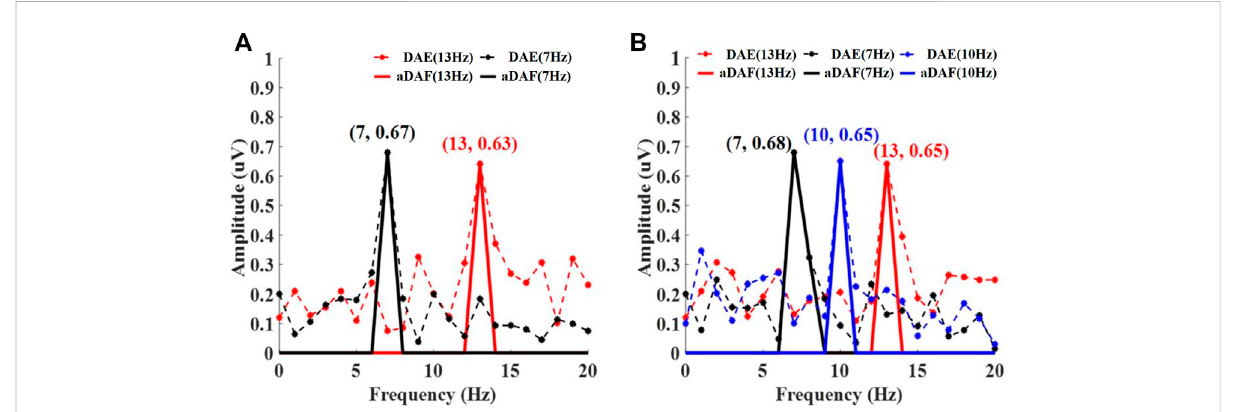
FIGURE 5 The decoded frequency spectrum results for multi-source with different frequencies, including (A) 2-sourceand (B) 3-source. In (A) , Black and red curve represent the spectrum corresponding to S1+ (7 Hz) and S2+ (13 Hz) respectively. In (B) , Black, blue and red curve represent the spectrum corresponding to S1+ (7 Hz), S2+ (10 Hz) and S3+ (13 Hz), respectively.